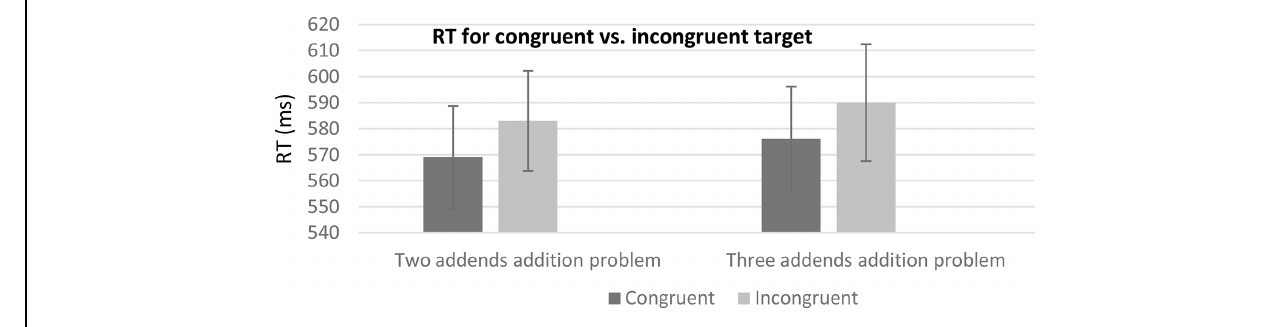
FIGURE 5 | Mean RT as a function of the different experimental conditions. Error bars represent standard error